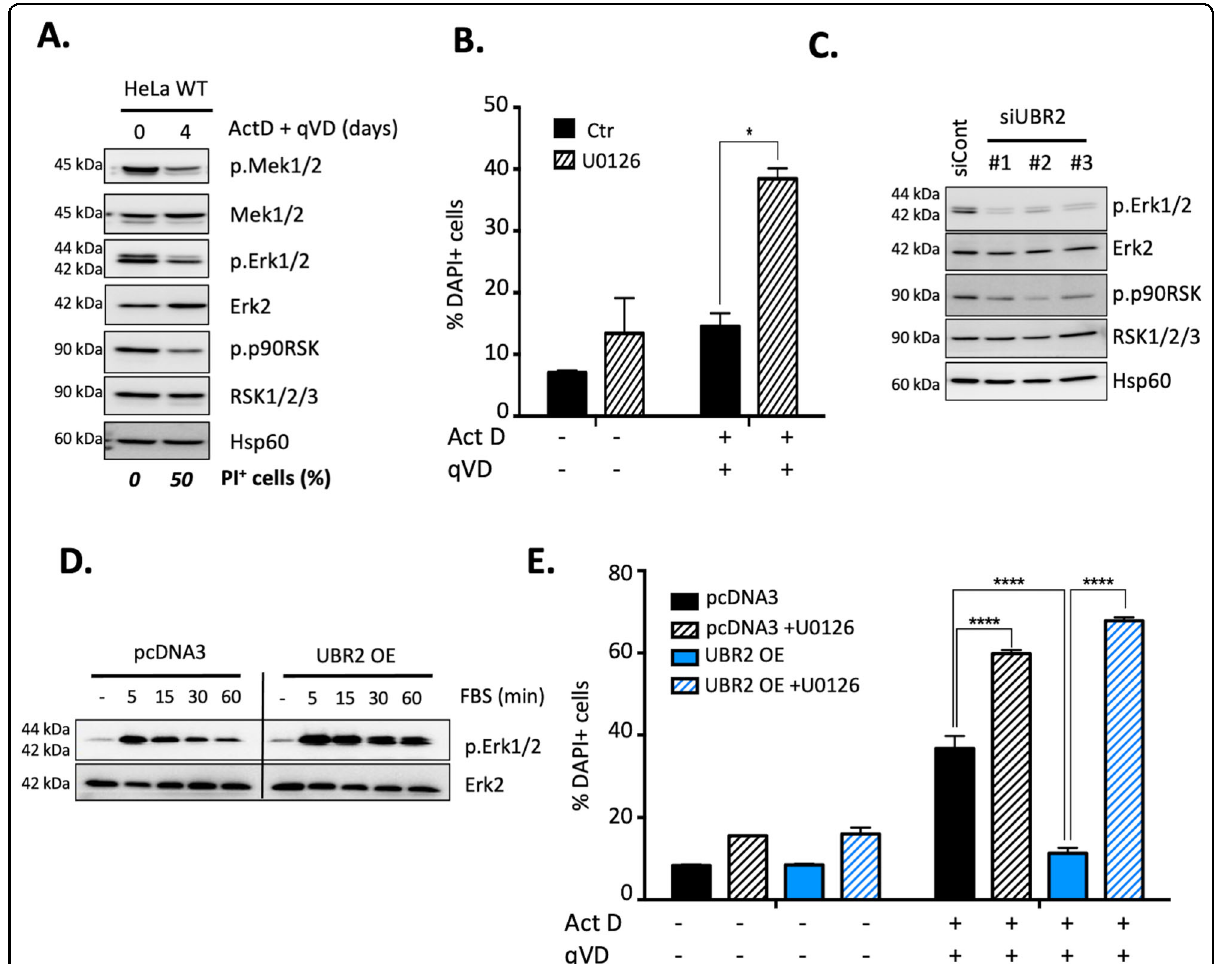
Fig. 5 UBR2 protection towards CICD depends on MAPK/Erk signaling pathway. A HeLa cells were treated with Actinomycin D (1 µM) and qVD- OPH (20 μ M) for 4 days and the MAPK/Erk pathway was assessed by immunoblots. Activation was assessed by looking at the phosphorylation state of Mek1/2, Erk1/2, and p90Rsk. Hsp60 was used as a loading control. % of PI positive cells are indicated below the immunoblots. B HeLa cells were treated as previously or in combination with the MEK1/2 inhibitor U0126 (10 μ M) for 24 h. Cell death was measured by fl ow cytometry using a DAPI staining. C HeLa cells were transfected with the three independent siRNA targeting UBR2. 48 h later, whole-cell lysates were analyzed for p.Erk1/2, Erk1/2, p.p90RSK, and RSK1/2/3 by immunoblotting. Hsp60 was used as a loading control. D HeLa cells were transfected to transiently overexpress the control vector (pcDNA 3 ) or UBR2-His-tagged. After 24 h, cells were cultivated without serum for 16 h and the next day were stimulated with 10% FBS for the indicated times. Whole cell lysates were analyzed for p.Erk1/2 and Erk2 (used as a loading control). E HeLa cells were transfected to transiently overexpress (OE) the control vector (pcDNA 3 ) or UBR2-his-tagged and were treated with Actinomycin D (1 µM) + qVD-OPH (20 μ M) alone or in combination with the MEK1/2 inhibitor U0126 (10 μ M) for 3 days. Cell death was measured by fl ow cytometry using a DAPI staining. Data are expressed as mean ± s.d ( n = 3) immunoblots are representative of 3 individual experiments. * p < 0.05, **** p < 0.0001, N.S: non-signi fi cant according to a two-way